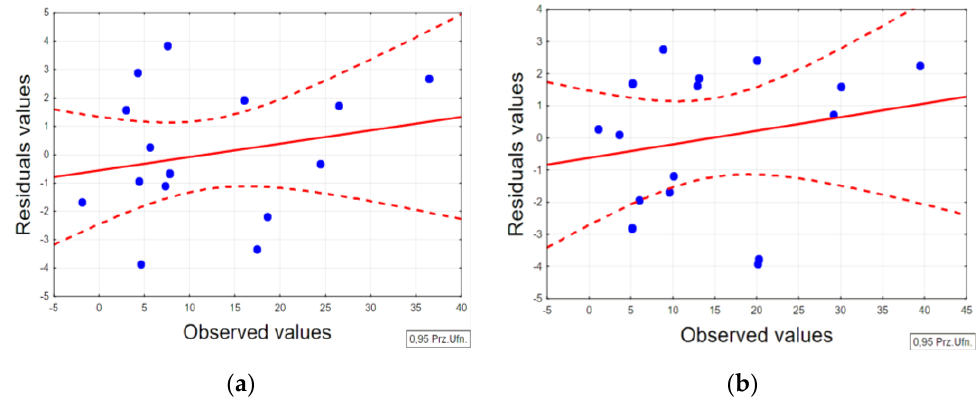
Figure 6. Plots of residual values as a function of observed values for TWR models of ( a ) AF-5 and ( b ) S-180 graphite electrodes. ( b ) S-180 graphite electrodes.